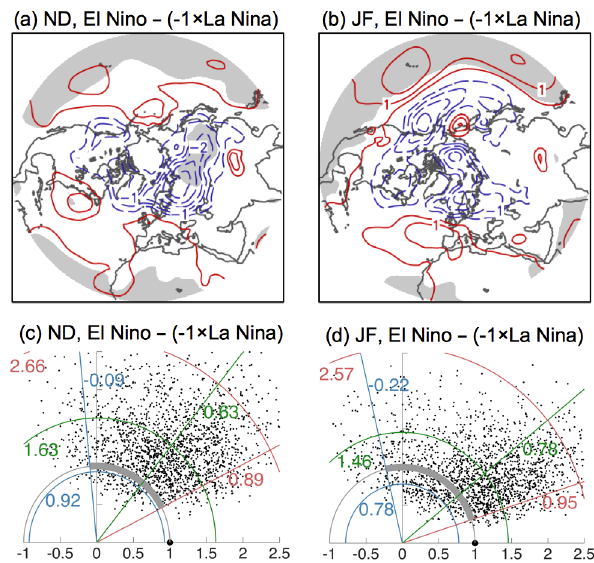
Figure 6. (a, b) Asymmetrical portion (El Niño − ( − 1 × La Niña)) of the ENSO teleconnection composites in Fig. 5. Red (blue) con- tours indicate positive (negative) anomalies, with gray shading in- dicating the 5% significance level for a two-tailed t test (the null hypothesis is the difference of El Niño, and − 1 × La Niña is statis- tically indistinguishable from zero). The contour interval is 0.5hPa. (c, d) Taylor diagrams for the North Atlantic with 2000 bootstrap composites of El Niño − ( − 1 × La Niña), as shown in panels (a) and (b) . Features in the Taylor diagram are as described in Fig. 2. See Sect. 3.2 for more